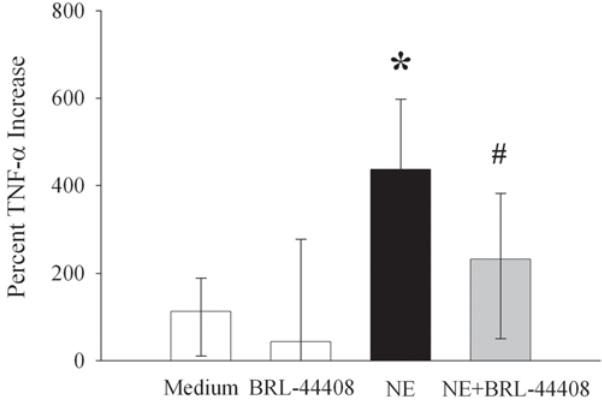
Figure 3. Stimulation with NE increases TNF- a release from KCs via a 2A -ARs. Alterations of TNF- a after stimulation of isolated KCs with NE (20 nM) with or without BRL-44408 maleate (1 m M), a specific a 2A -AR antagonist, for 4 h. Percentage values (n=6/group) are presented as mean 6 95% confidence and compared by ANOVA on Ranks and Student-Newman-Keul’s method. *P , 0.05 vs. Medium; # P , 0.05 vs.